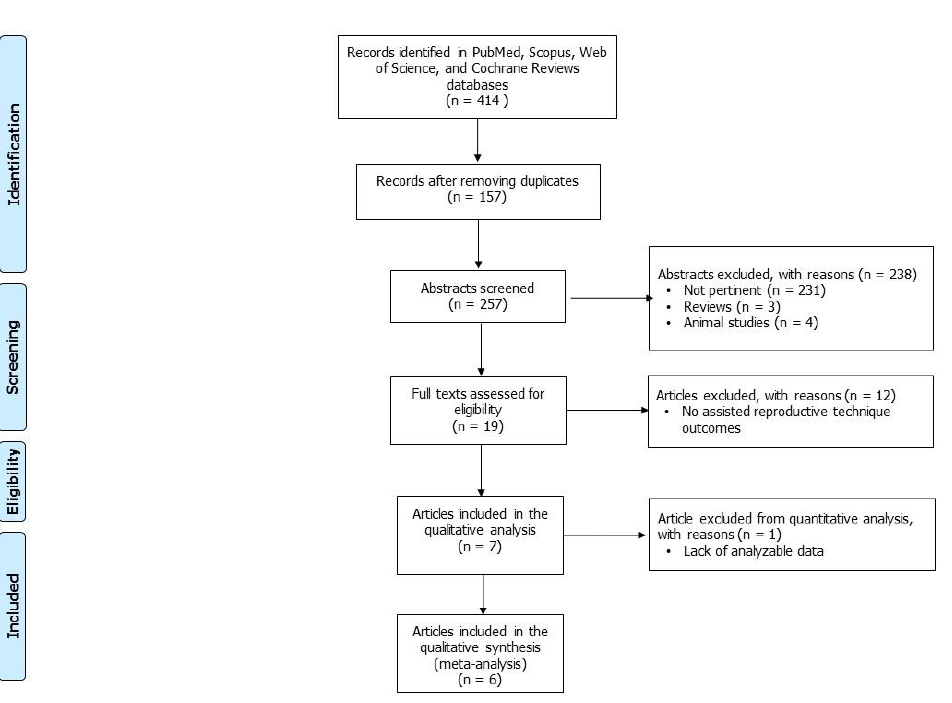
Figure 1. Flowchart of included studies. Table 2. Evaluation of study quality using “The Cambridge Quality